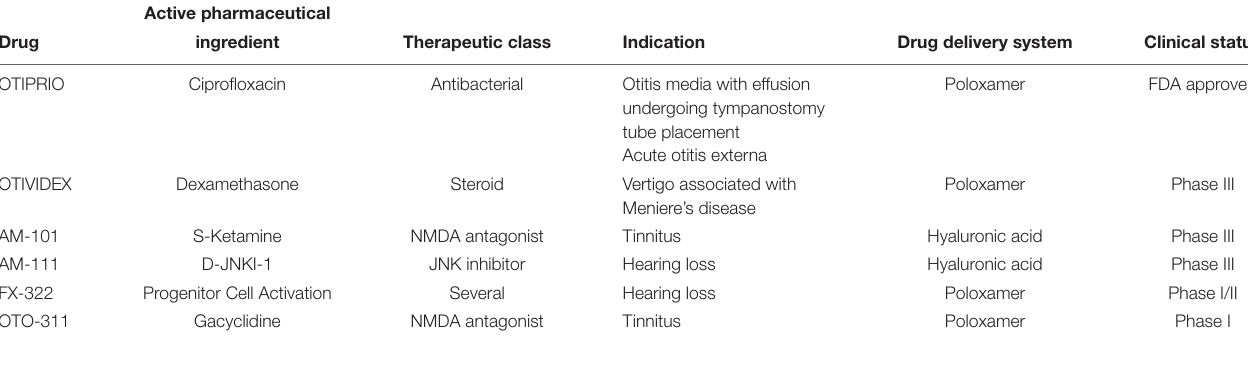
TABLE 3 | Novel formulations for intratympanic delivery that have entered clinical